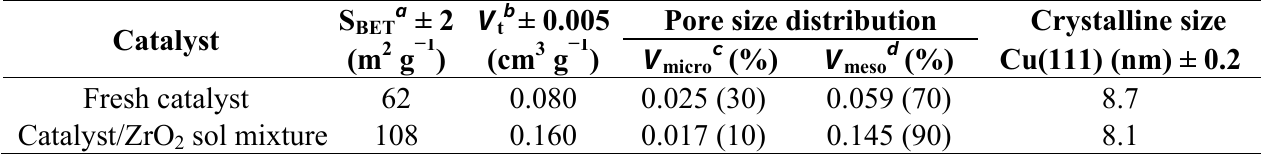
Table 2. Specific surface area/pore size distribution of fresh catalysts and catalyst/ZrO mixtures using BET nitrogen isotherms and crystalline size of copper